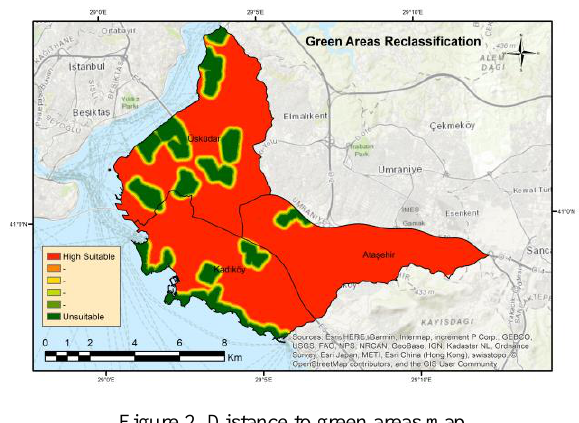
Figure 2. Distance to green areas